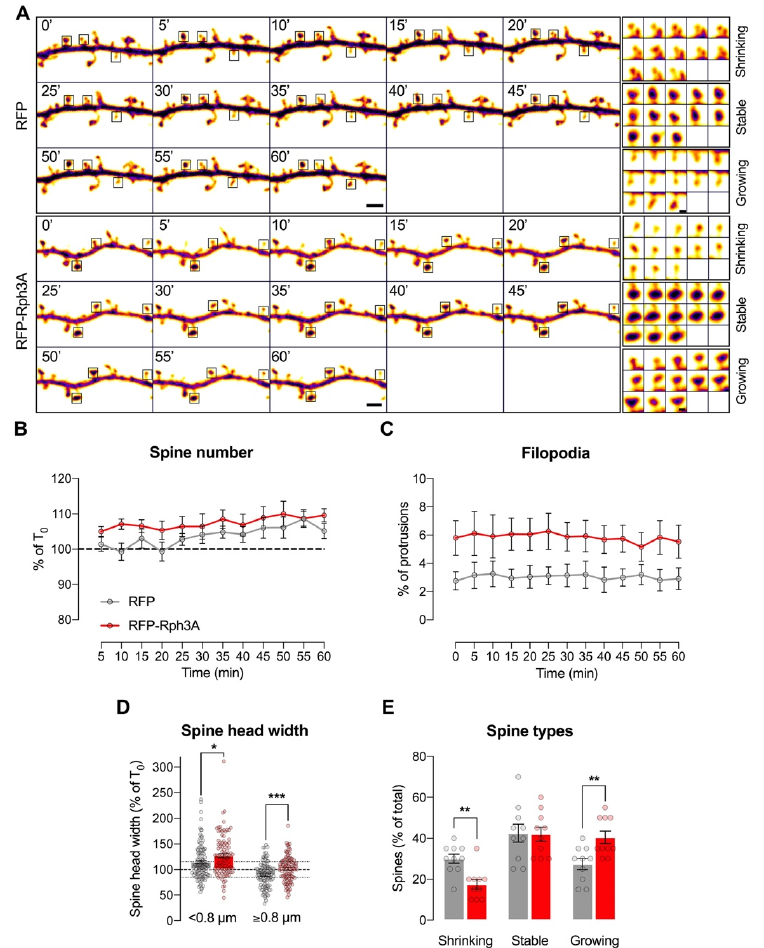
Figure 3. Rph3A overexpression in live-imaging of dendritic spines. ( A ): Confocal time lapse images of GFP filler in the dendritic spines of RFP ( up ) or RFP-Rph3A ( down ) transfected neurons. Scale bar: 2 µ m. Inserts show examples of shrinking, stable and growing spines for each condition. Scale bar: 0.5 µ m. ( B ): XY graph representing mean ± SEM spine number as a percentage of T